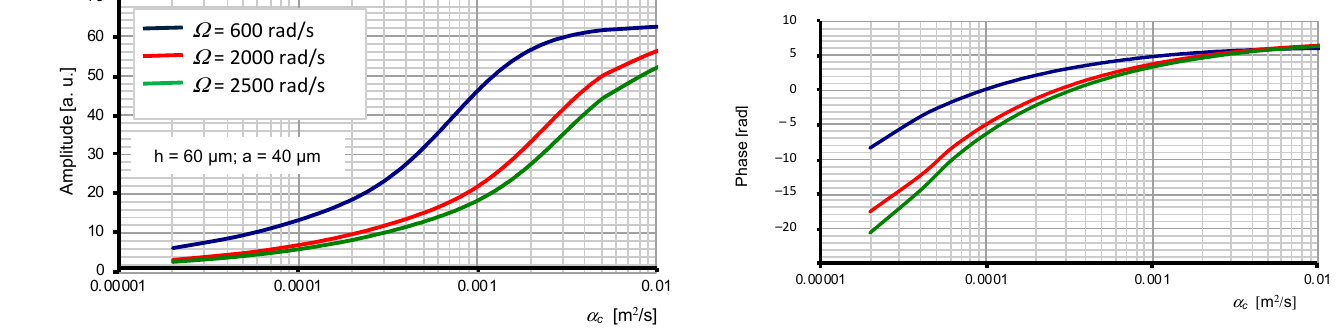
Figure 7. Theoretical BDS amplitude and phase dependence on the values of thermal diffusivity of coating deposited on bulk support for PB height over the sample of 60 μ m and its radius in the waist of 40 μ m and for different modulation frequencies of the excitation beam (60, 600, 2000 rad/s).